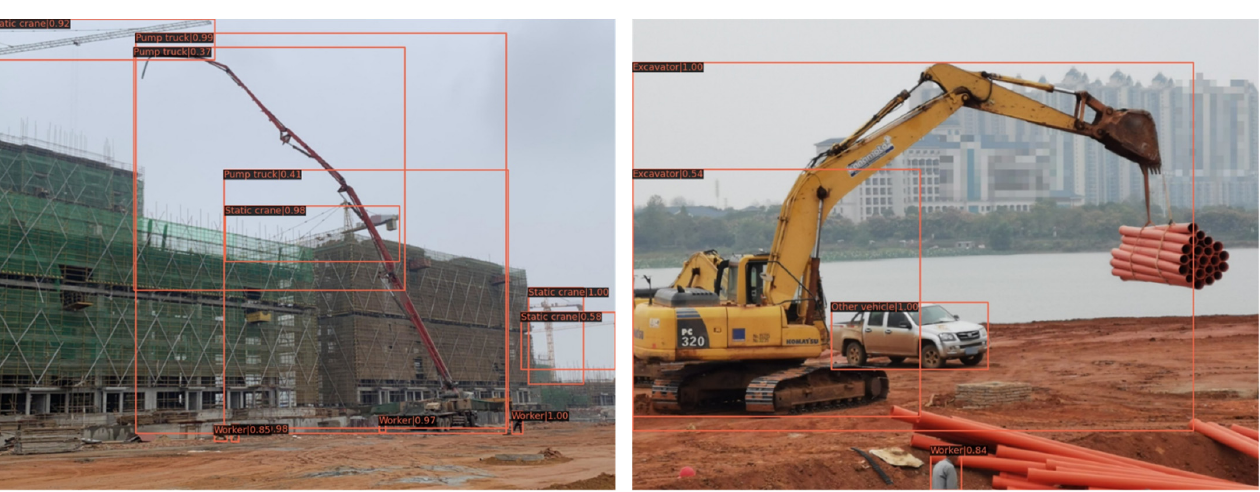
Figure 1. Bounding box redundancy problem for object detection at a construction site.